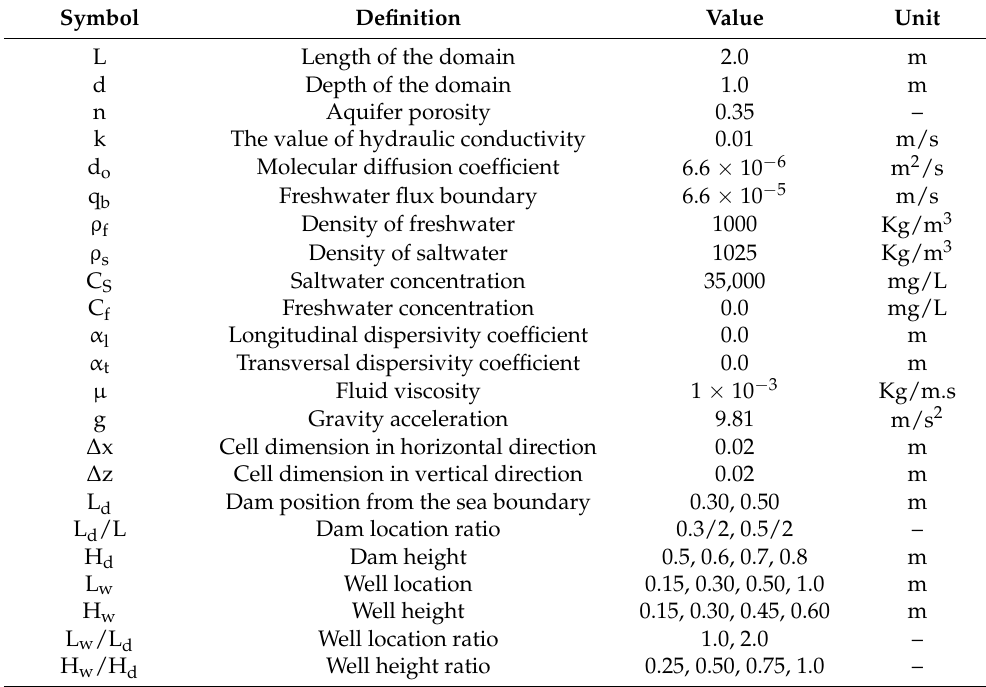
Table 1. Numerical simulation